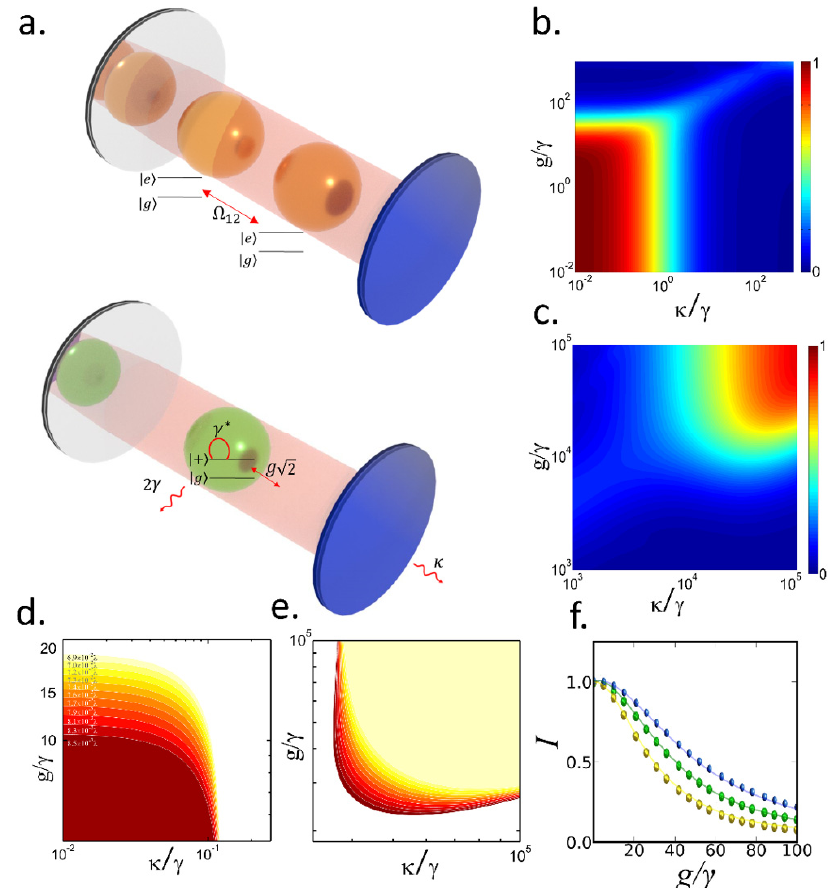
Figure 1. ( a ) The two interacting QEs with γ coupled to the cavity field with g are equivalent to a √ single QE with 2 γ coupled to the cavity with 2 g , each sphere represents a single two-level-system. Indistinguishability of the effective QE versus the normalized κ and g in the ( b ) incoherent regime and ( c ) coherent regime. Contour map of regions with I > 0.9 for different distances between the emitters from d = 6.9 × 10 − 2 λ to d = 8.5 × 10 − 2 λ ( d ) incoherent regime and ( e ) coherent regime. ( f ) Indistinguishability versus normalized g for d = 7.2 × 10 − 2 λ (yellow), d = 7 × 10 − 2 λ (green) and d = 6.9 × 10 − 2 λ (blue); solid lines calculated using Equation (1); colored dots obtained from numerical integration of the Lindblad equation with two QEs.